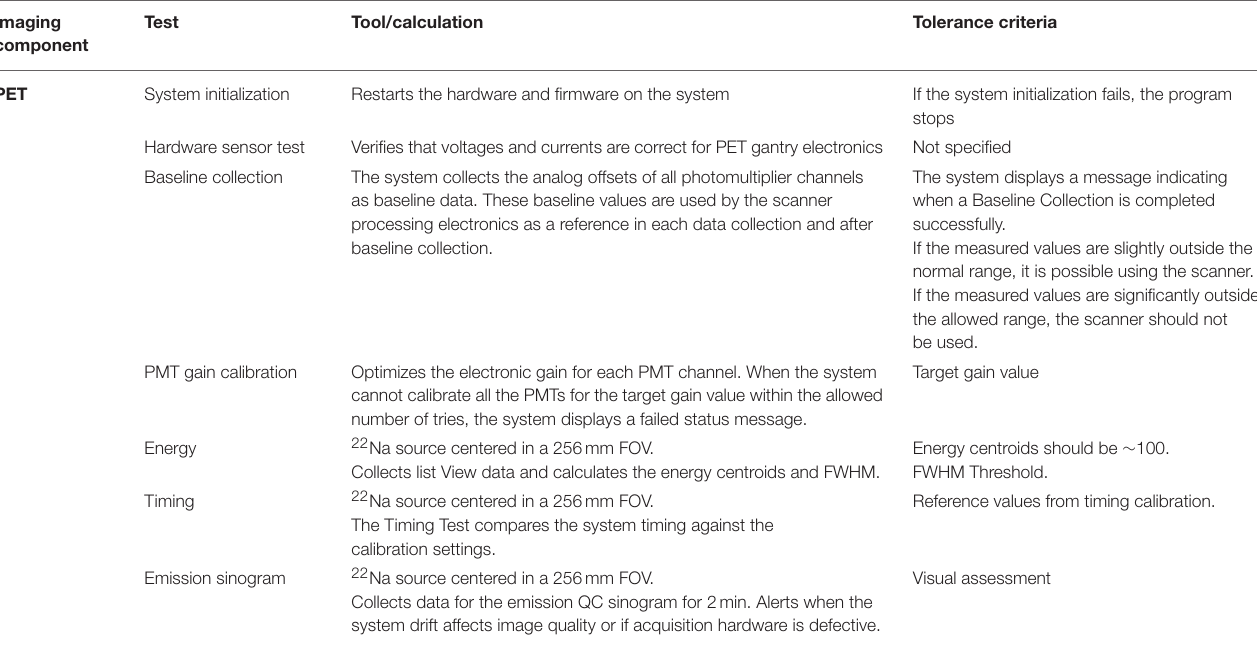
TABLE 6 | DQA tests for Philips Ingenuity TF PET/MR systems. Imaging